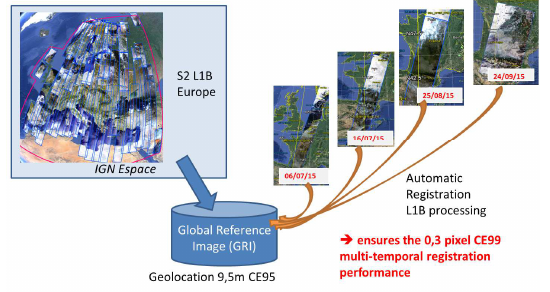
Figure 18. Refining and multi-temporal process with GRI.